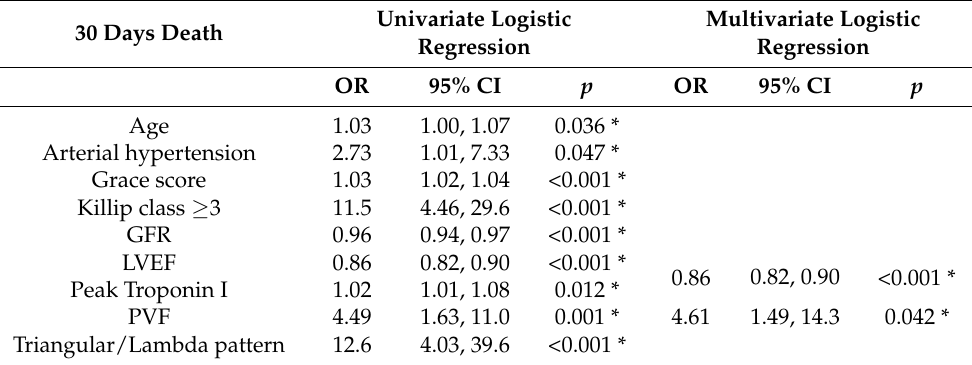
Table 5. Predictors of 30-day mortality at logistic regression analysis.